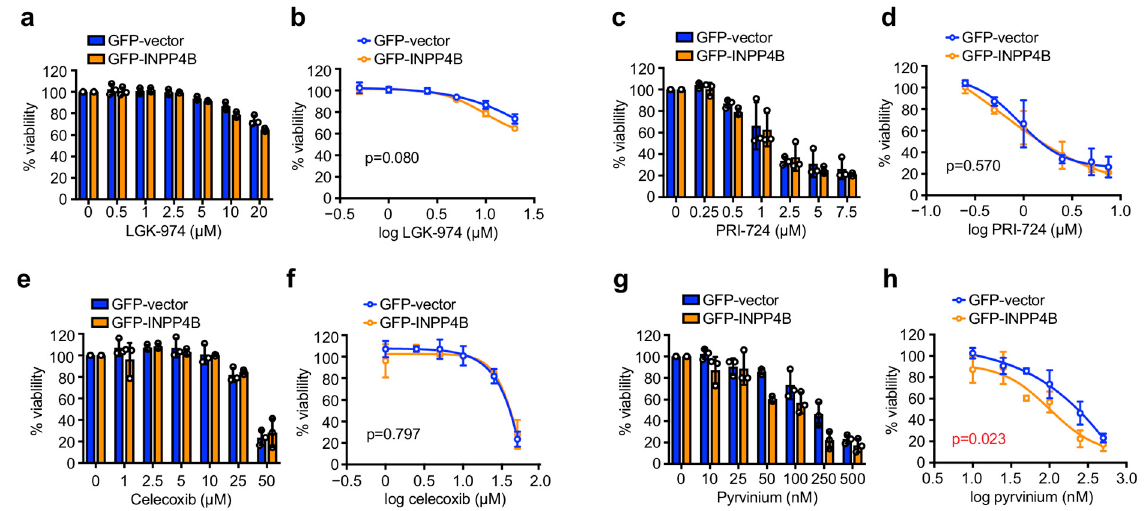
Figure 2. INPP4B-overexpressing MCF-7 cells are more sensitive to pyrvinium in monolayer culture. MCF-7 cells expressing GFP-vector or GFP-INPP4B were treated with 0.5–20 µ M LGK-974 ( a , b ), 0.25–7.5 µ M PRI-724 ( c , d ), 1–50 µ M celecoxib ( e , f ), 10–500 nM pyrvinium ( g , h ) or DMSO as a vehicle control for 48 h, then cell viability was assessed using CellTiter-Glo ® assays. Data represent the relative cell viability normalized to untreated cells ( a , c , e , g ), or plotted as a 4-parameter logistical regression ( b , d , f , h ) ± SD ( n = 3 experiments). p values were determined by two-tailed unpaired t test of the area under the curve in ( b , d , f , g ).